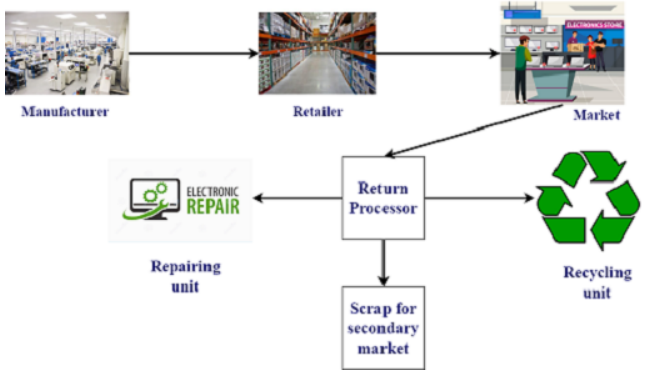
Figure 1. Proposed framework of the forward and reverse SCs of electronic